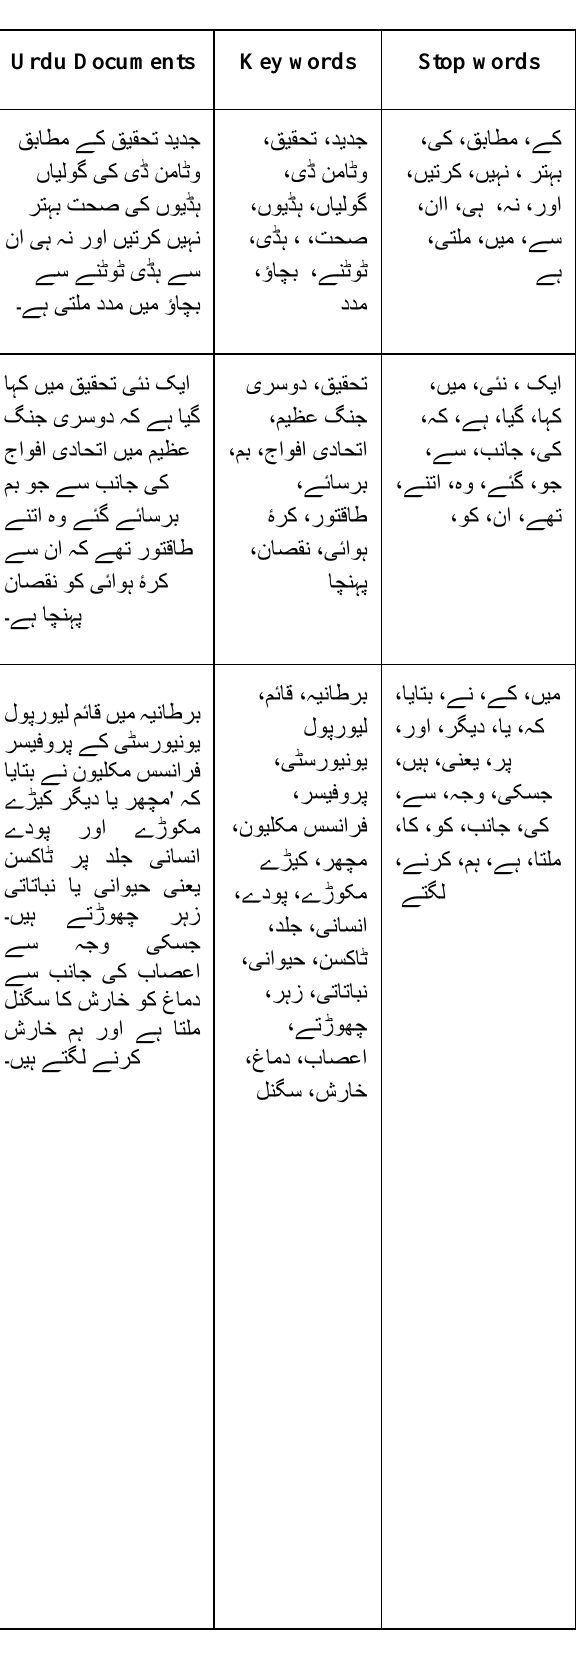
Table 3 Example of Urdu Stop words and Key words